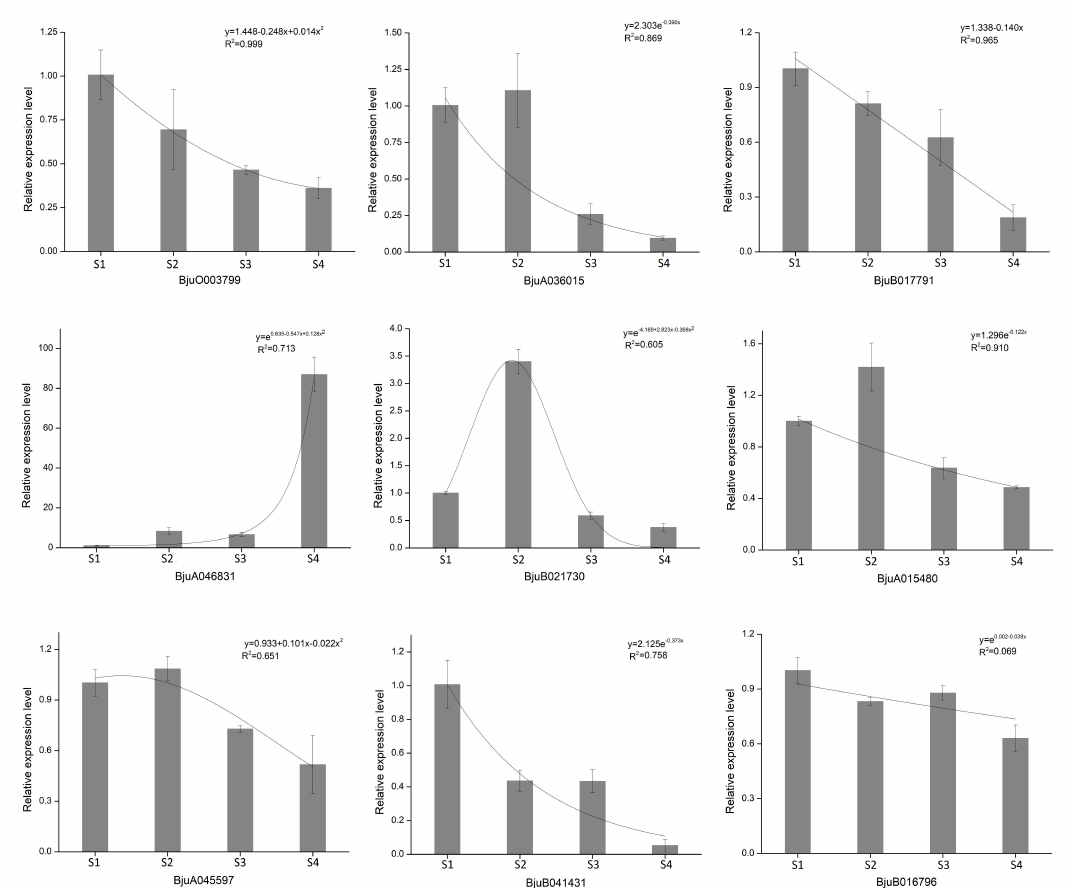
Figure 8. qPCR analysis of DEGs involved in glucosinolate biosynthesis in stem mustard.